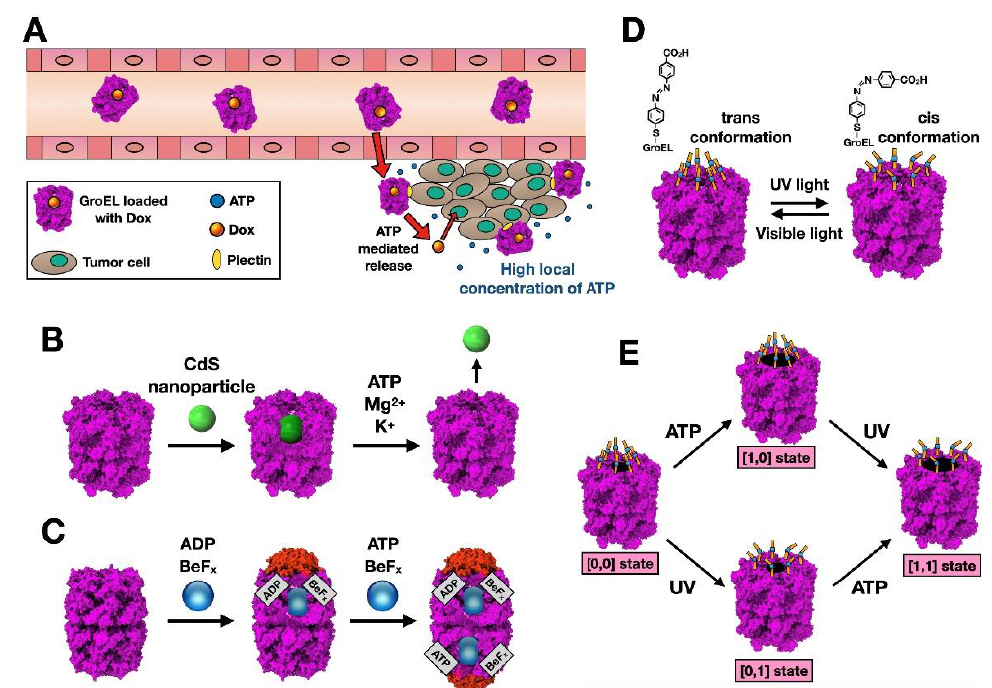
Figure 2. Nanotechnological applications for Type I chaperonins. ( A ) Proposed mechanism of action for GroEL-Dox in drug delivery and release to tumor cells. Modified from [15]. ( B ) The chaperonin-enclosed CdS nanoparticles and their ATP-induced release. As shown, CdS nanoparticles can be encapsulated inside of the chaperonin, and released in the presence of ATP and different ions. Modified from [16]. ( C ) The reaction scheme of nanoparticles encapsulation in the GroEL/GroES complex. In the presence of ADP and BeFx, a 1:1 GroEL:GroES (“bullet”) is formed, while incubation with ATP and BeFx induces the formation of a 1:2 GroEL:GroES complex (“football”). This allows the possibility of caging different nanoparticles in each of the chaperonin’s cavities. Modified from [17]. ( D ) Structural changes induced by the trans-cis isomerization of azobenzene-modified GroEL. ( E ) ‘AND’ logic response of azobenzene-modified GroEL to ATP (which induces the chaperonin to an open conformation) and UV (which induces opening of the chemical gate). The chaperonin cavity opens efficiently only in the presence of both stimuli; modified from [19].